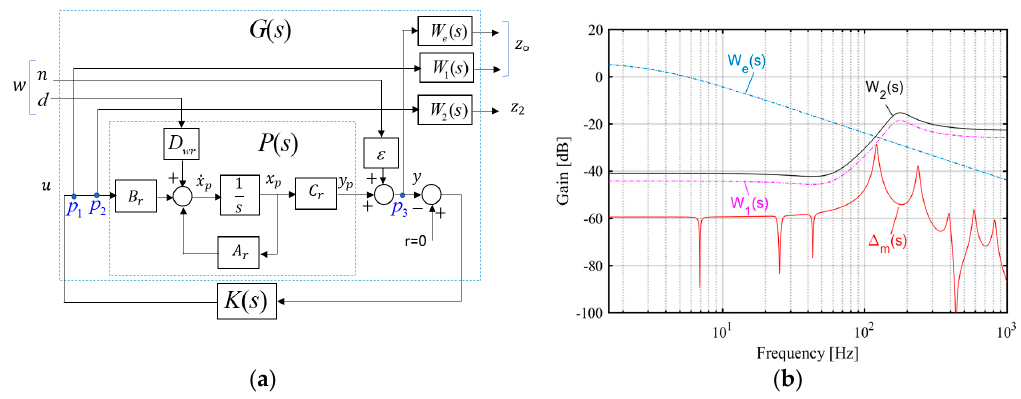
Figure 12. Multi-objective control design approach ( a ) the block structure, ( b ) frequency responses of the weighting filters and uncertainty.